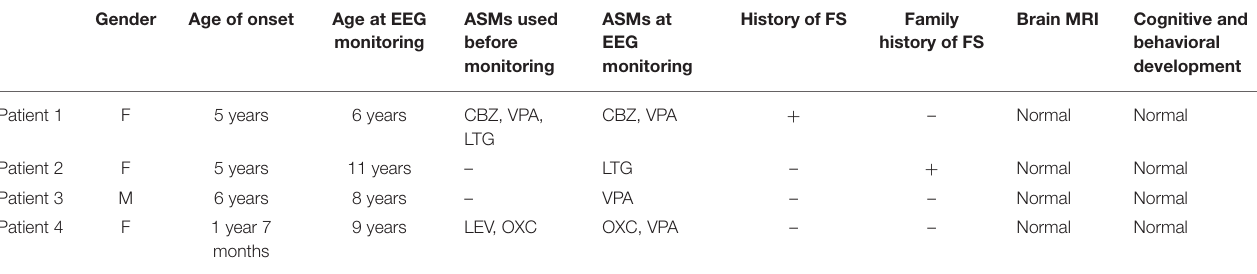
TABLE 1 | Summary of the clinical features of four